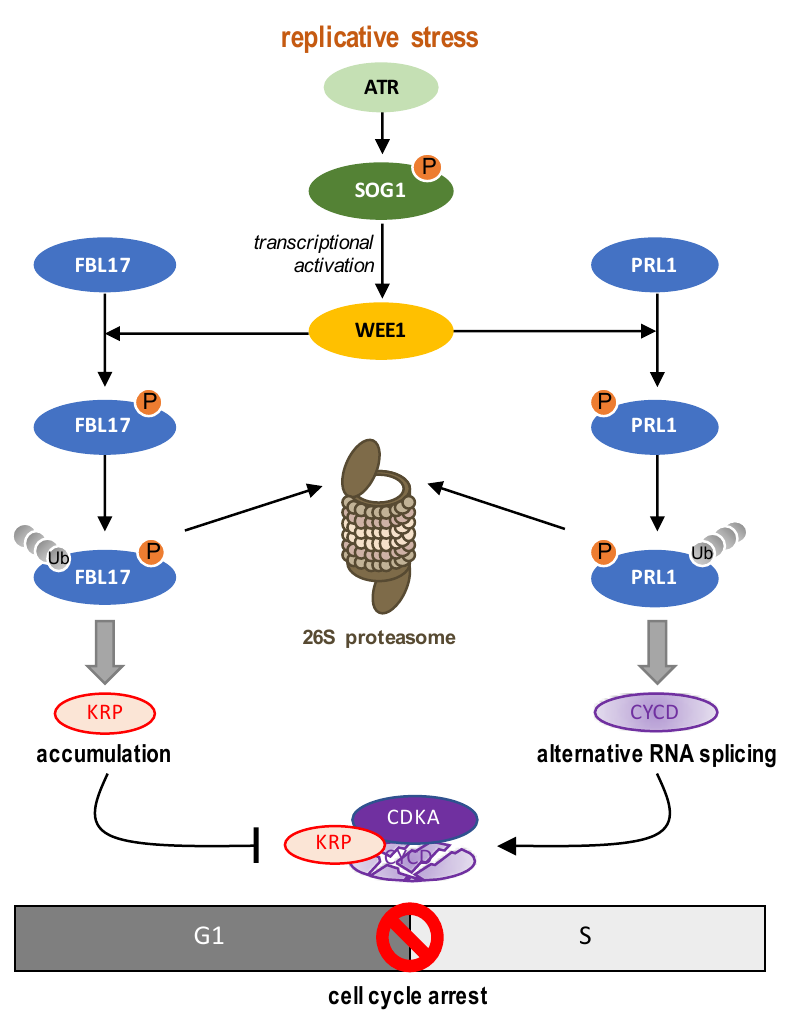
Figure 3. Upon replicative stress, WEE1 targets at least two substrates to efficiently establish a block- age in G1/S transition. As an important DDR player in plant, WEE1 is activated in an ATR/SOG1- dependant manner. If WEE1 implication during G2/M phase transition has been already described, recent works highlight its implication during the G1/S phase transition. 1—By phosphorylating the FBL17 E3 ubiquitin ligase, WEE1 triggers its proteasome degradation resulting in further accumula- tion of KRPs, which block the cell cycle progression [123]. FBL17 being also recruited at DNA lesion sites could target other regulators to fine tune DNA repair mechanisms [112]. 2—By targeting PRL1 a subunit of the MAC complex involved in RNA splicing, WEE1 promotes its selective degradation resulting in a non-functional MAC complex. As a consequence, CYCD mRNAs are not properly spliced compromising the activation of CDKAs and the cell cycle progression